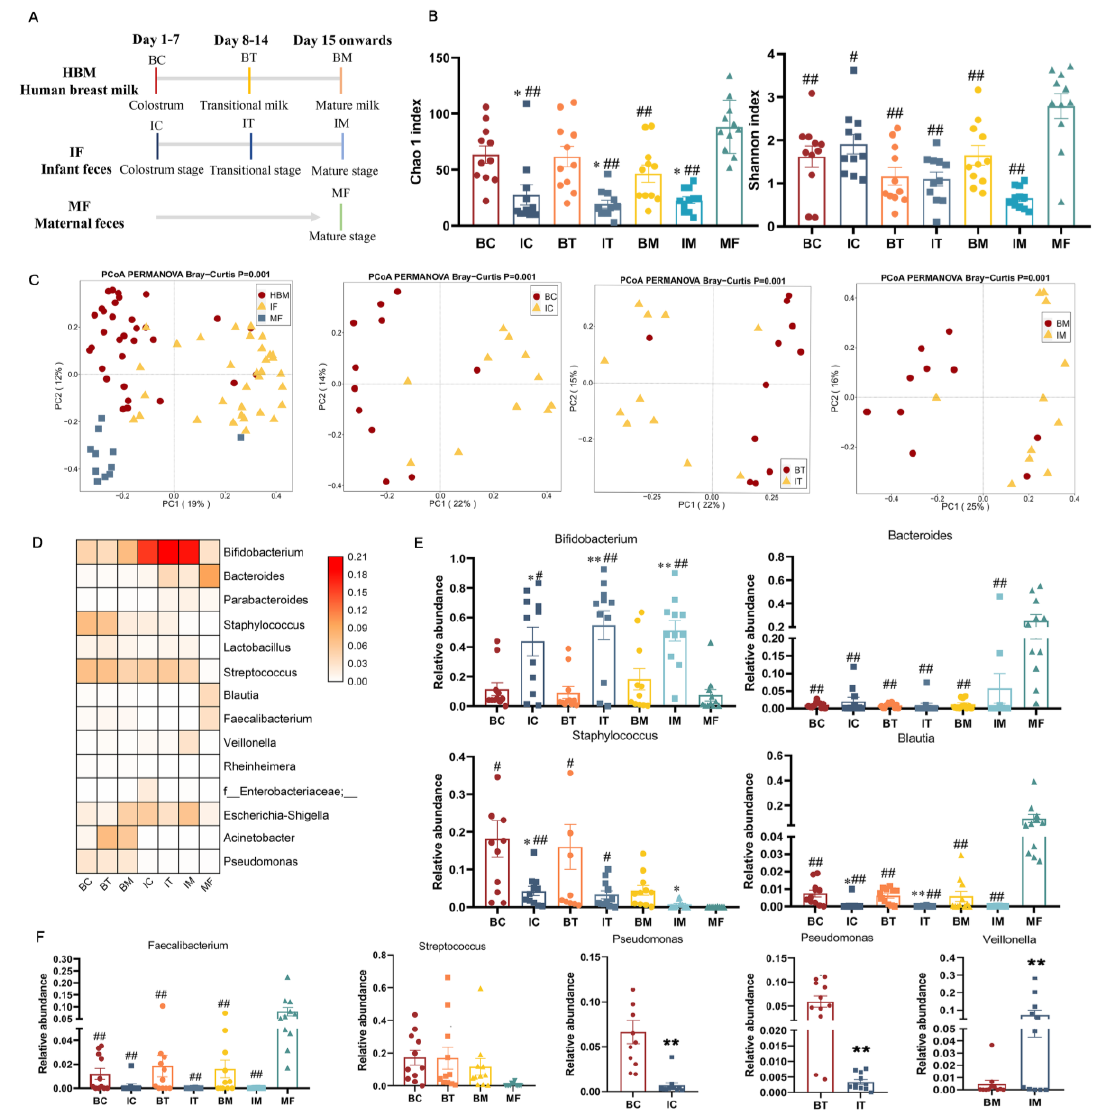
Figure 1. Diversity and composition of total bacteria in HBM and infant and maternal feces. ( A ) Sample collection type and time point. ( B ) Alpha diversity. ( C ) Beta diversity. PERMANOVA was used to calculate differences among samples based on Bray – Curtis distance. ( D ) Heatmap of total bacterial composition in HBM and infant and maternal feces. Genera of relative abundances > 0.01% and calculated with log10 are presented. The darker color corresponds to higher relative abundance. ( E , F ) Significant difference of genera between different samples. *, p < 0.05; **, p < 0.01three stages of infant feces compared to BC, BT, and BM. #, p < 0.05; ##, p < 0.01, three stages of HBM and infant feces compared to maternal feces. HBM, IF, and MF stand for group human breastmilk and infant and maternal feces. BC, BT, BM, IC, IT, and IM stand for colostrum, transitional milk, mature milk, and infant feces corresponding to HBM stages.